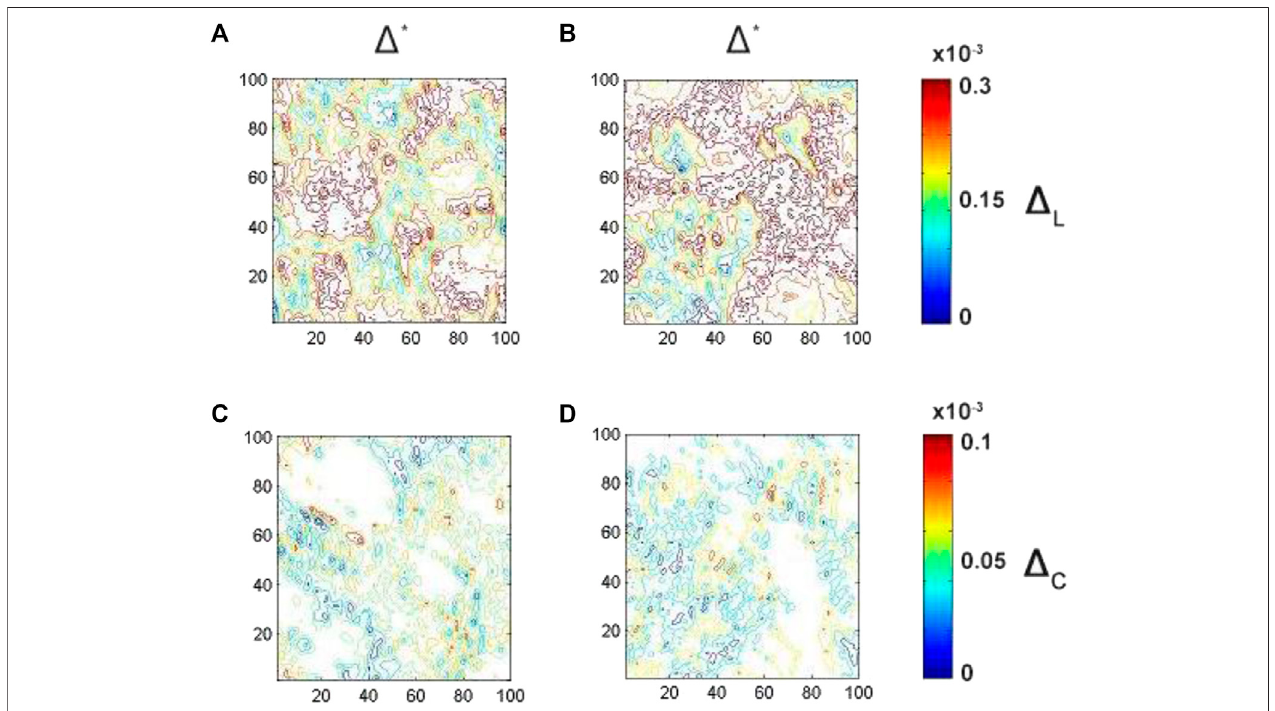
FIGURE 9 | Embossed topographic maps of linear (A, B) and circular (C, D) dichroism of ACI (left column) and CHD (right column) myocardial histological sections. The determined optimal phase planes are θ p ( Δ L , Δ C ) (cid:1) 0 . 55rad.